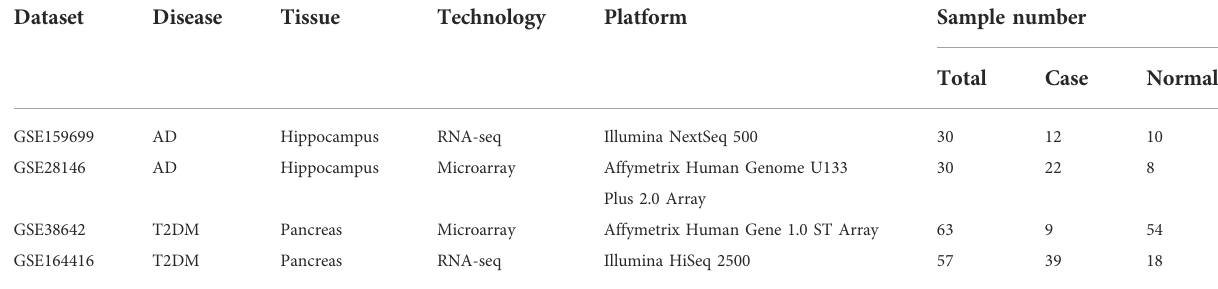
TABLE 1 AD and T2DM gene expression